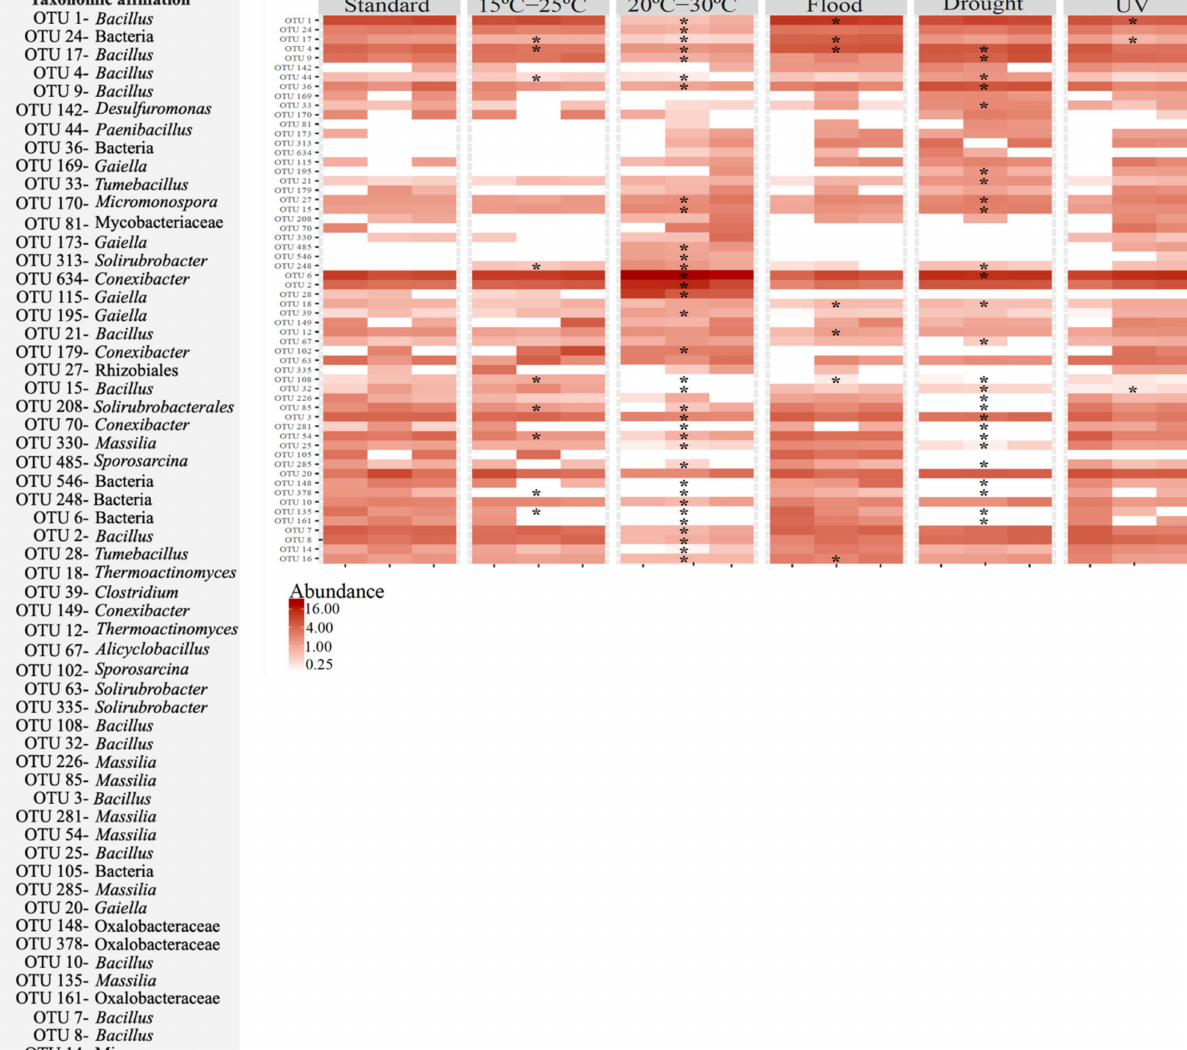
Figure 5. Heatmap for the most heavily represented OTUs (30 most abundant) in Lufa 2.2 soil without the presence of the soil invertebrate E. crypticus after exposure to each scenario for 48 h. The color codes represent the relative abundance of OTUs in each soil replicate ( n = 3). Standard refers to the conditions recommended by the standardized OECD guidelines. The symbol * indicates statistical differences compared to standard conditions based on one-way ANOVA followed by Dunnett’s post hoc test ( p < 0.05). UV